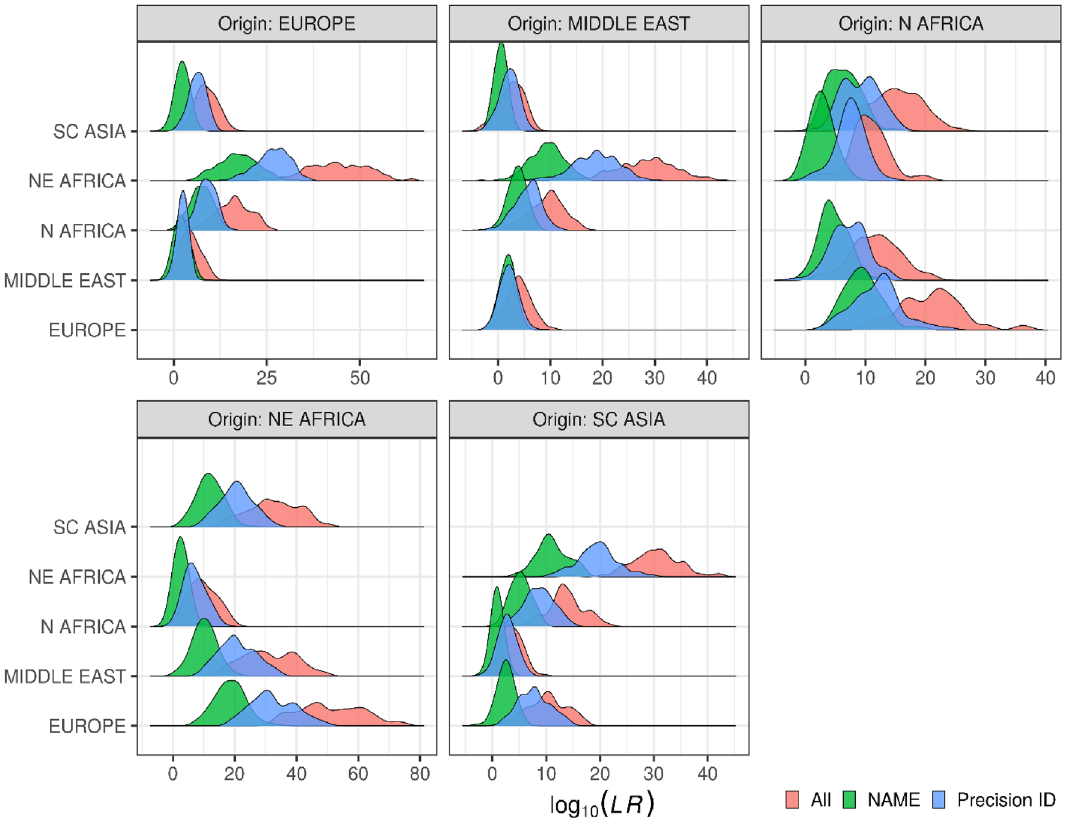
density estimates for the 1070 individuals. The hypothesized meta-population in the numerator of the LRs is given by the heading of each plot, while the hypothesized meta-population in the denominator is indicated to the left of the ordinate. R v. 3.5.0 and the ‘ggplot2’ v. 3.2.1 R package (https:// ggplo t2. tidyv erse. org/ index. html) was used to visualise the